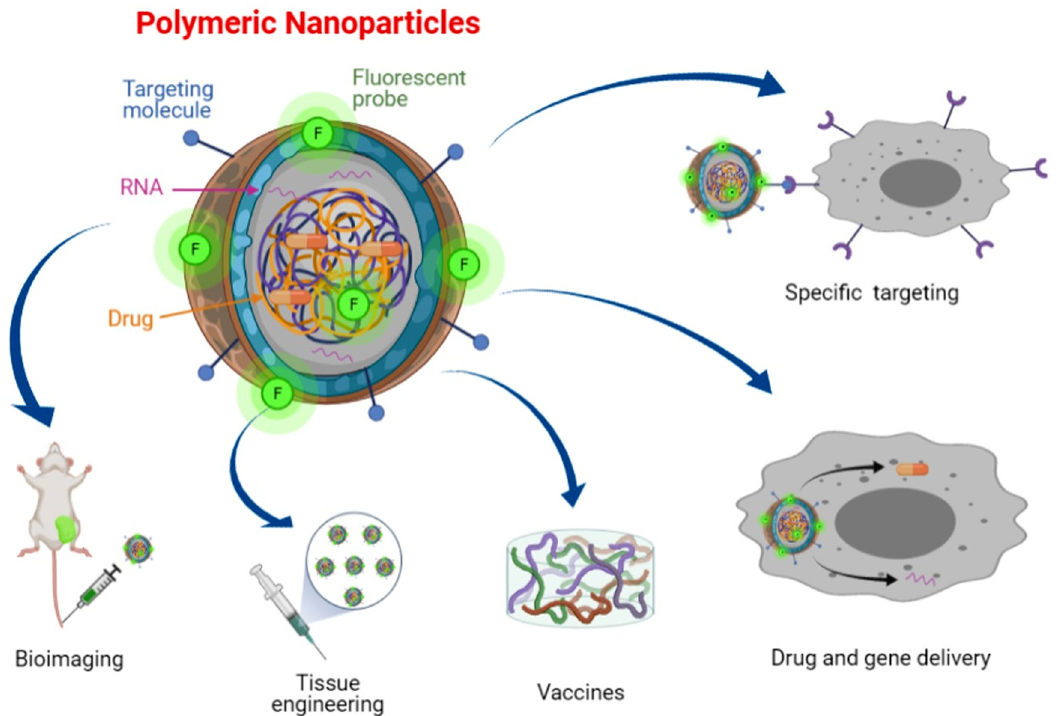
Figure 10: PNPs and their application in biomedical research. PNPs can be conjugated with targeting molecules ( speci fi c targeting ) ; with biological molecules including drugs and RNA ( drug and gene delivery ) and fl uorescence probes ( bioimaging ) . Furthermore, PNPs are amply used also in tissue engineering and